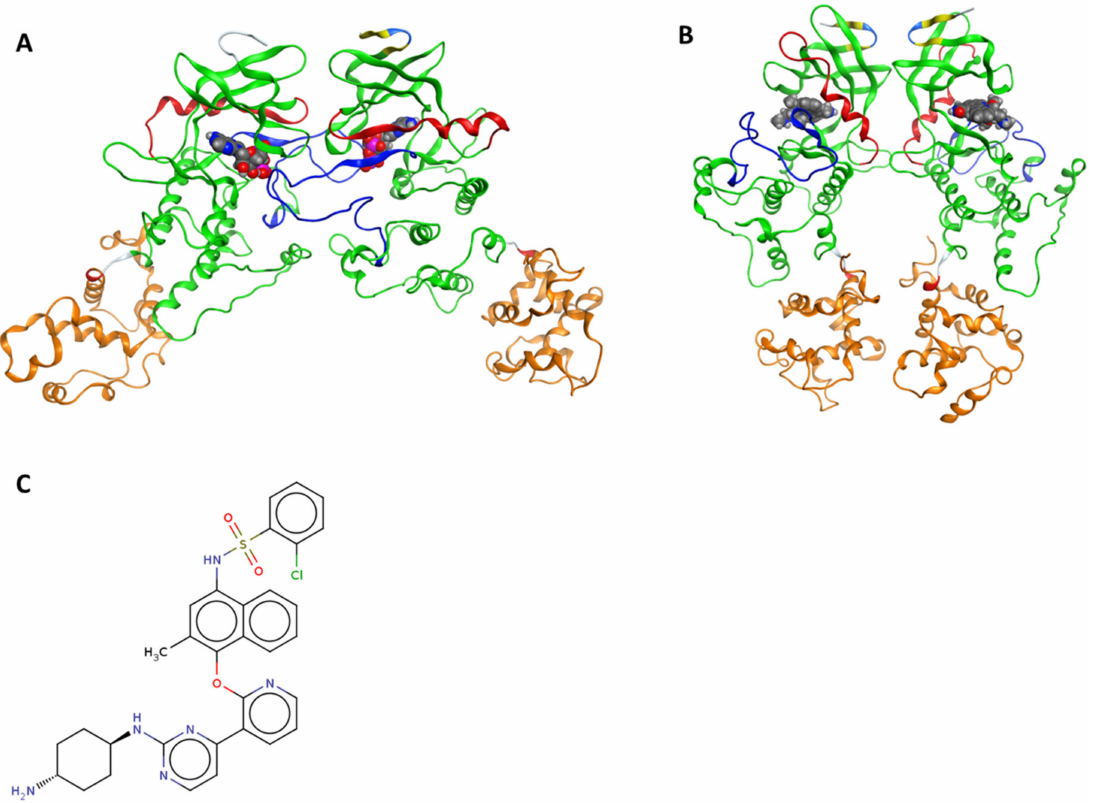
Figure 1. Ribbon diagram representing the dimeric structures of the inositol-requiring enzyme 1 α (IRE1) cytosolic regions. ( A ) Face-to-face dimer (PDB 3P23). ( B ) Back-to-back arrangement (PDB 4YZC). The kinase domain is shown in green (residues 571–832), the helix- α C in red (residues 603–623), the activation segment in blue (residues: 711–741), the RNase domain in orange (residues 837–963). The yellow segment represents the β -strand and the cyan the H-bonded turn that are not part of the kinase or RNase domain. ADP and staurosporine are highlighted in spaces filling models in ( A ) and ( B ), respectively, to indicate the kinase binding sites. ( C ) 2D molecular representation of Kinase inhibiting RNase attenuators